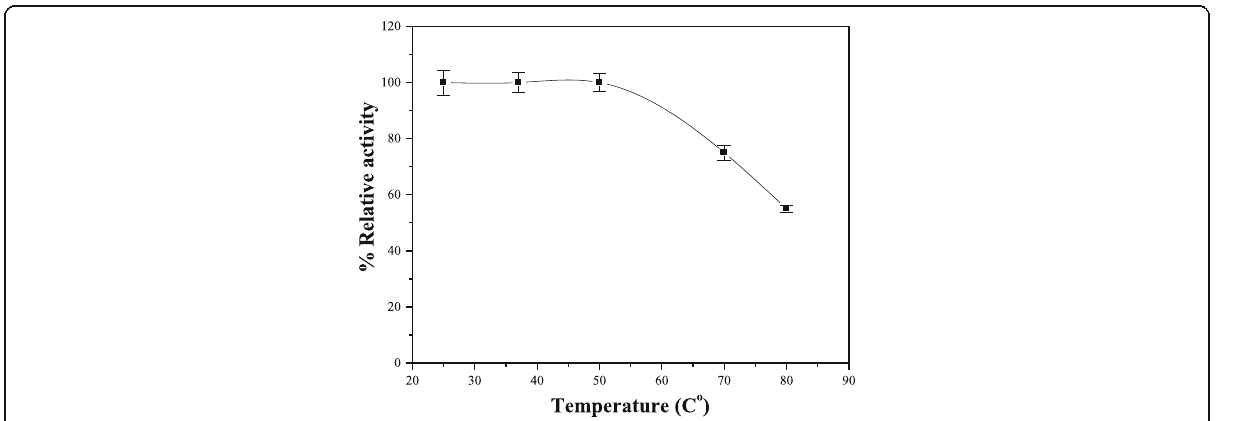
Fig. 8 Effect of temperature on the thermal stability of ginger GPII. The enzyme was preincubated at various temperatures for 1 h prior to substrate addition, followed by cooling in an ice bath. Activity at zero time was taken as 100% activity. The points are presented as mean ± S.E. ( n =